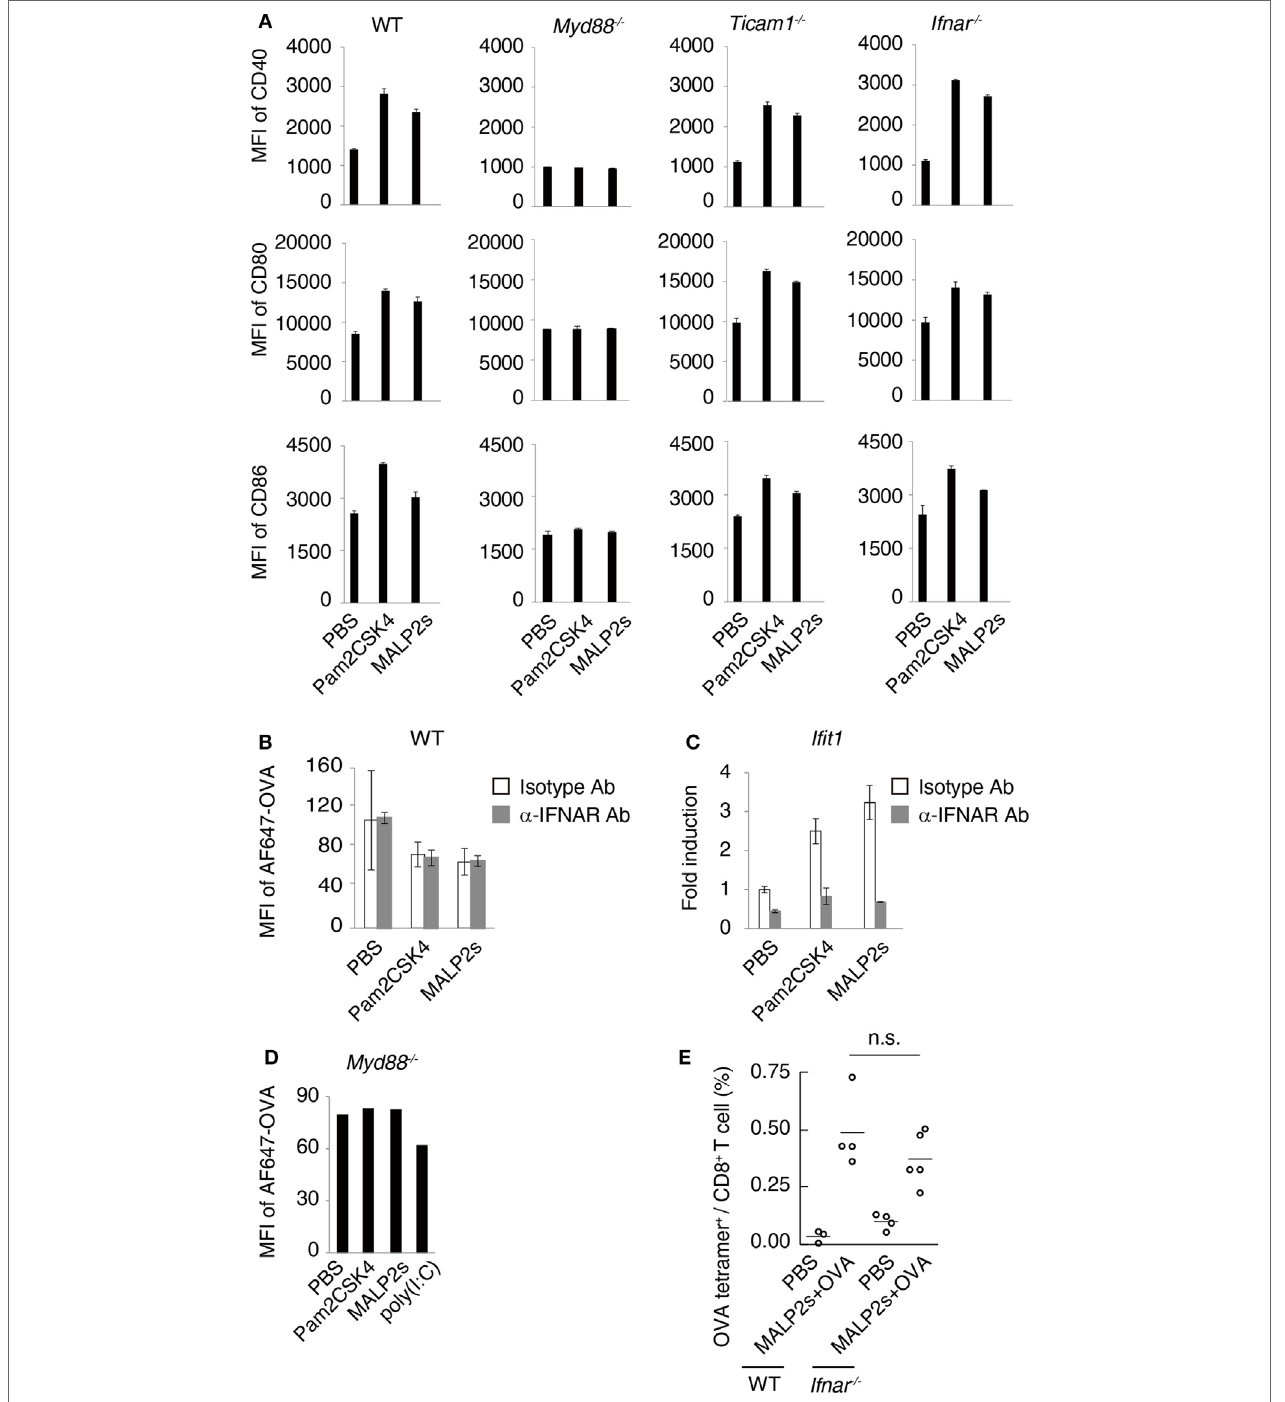
FigUre 2 | Myeloid differentiation primary response 88 (MyD88) but not TICAM-1-Type I interferon (IFN) pathway is responsible for MALP2s-induced dendritic cell (DC) maturation. (a) PBS, 100 nM of Pam2CSK4, or MALP2s was added in bone marrow-derived dendritic cells (BMDCs) derived from various gene knockout mice. After 18 h, CD40, CD80, and CD86 expression levels on DCs were analyzed by flow cytometry. (B,c) WT-derived BMDCs were pretreated by 10 µg/ml of isotype antibody (Ab) or α -IFNAR Ab. After 1 h, PBS, Pam2sCSK4, or MALP2s was added. (B) After 18 h, 10 µg/ml of AF647-OVA was added and DCs were incubated for 20 min. After washing out OVA, an endocytic activity was assessed by MFI of endocytosed AF647-OVA on BMDCs. (c) After 6 h, Ifit1 gene expression was analyzed by qPCR. (D) An endocytic activity of Myd88 − / − -derived BMDCs was assessed as in (B) . poly(I:C) was a positive control. (e) WT and Ifnar − / − mice were subcutaneously (s.c.) administered with PBS or MALP2s + OVA. After 7 days, the percentage of OVA-specific cells among splenic CD8 + T cells was analyzed by flow cytometry. (a–c) Error bars show ± SD. (e) n = 3 to 5 per group. Kruskal–Wallis test with Dunn’s multiple comparison test was performed to analyze statistical significance. n.s., not